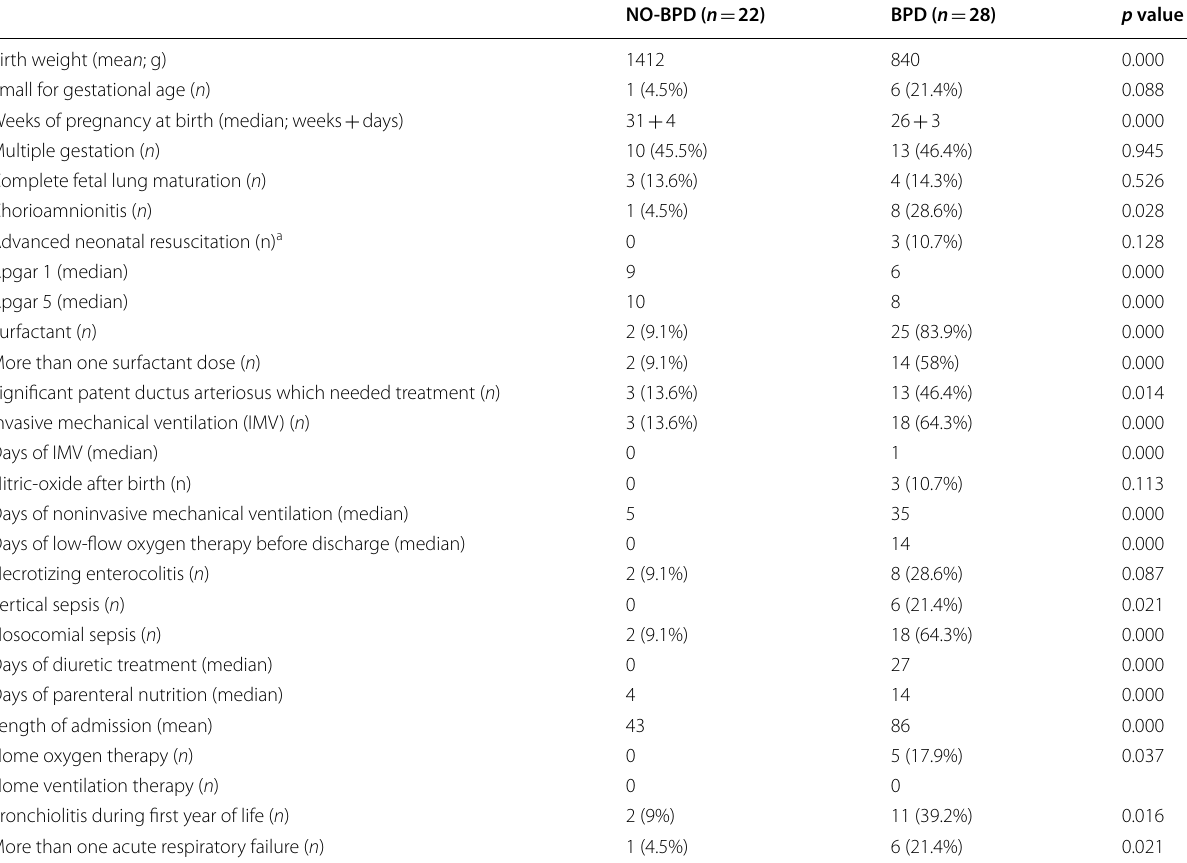
Table 1 Sample characteristics for both